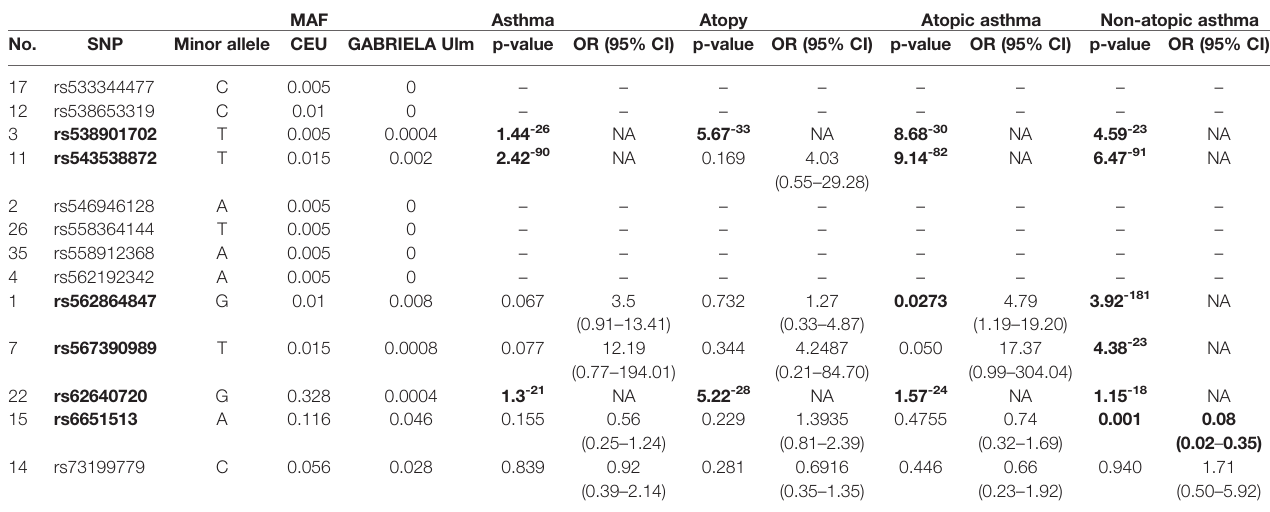
TABLE 1 | Genetic associations of SNPs in or nearby DEFB4A/B with asthma and atopy in the GABRIELA Ulm cohort (n=1,238). MAF Asthma Atopy Atopic asthma Non-atopic asthma